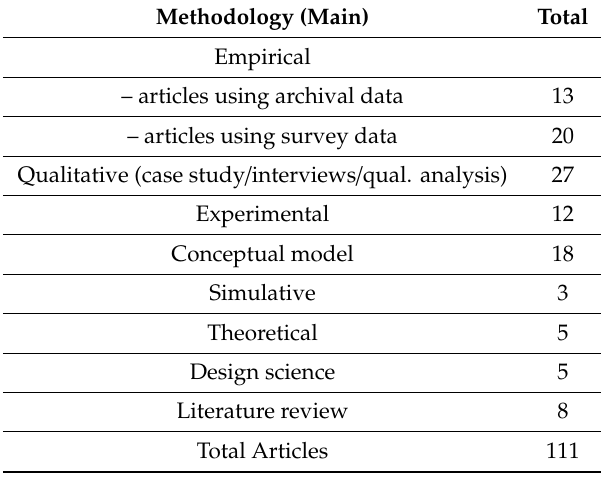
Table 3. Classification of articles by (main)